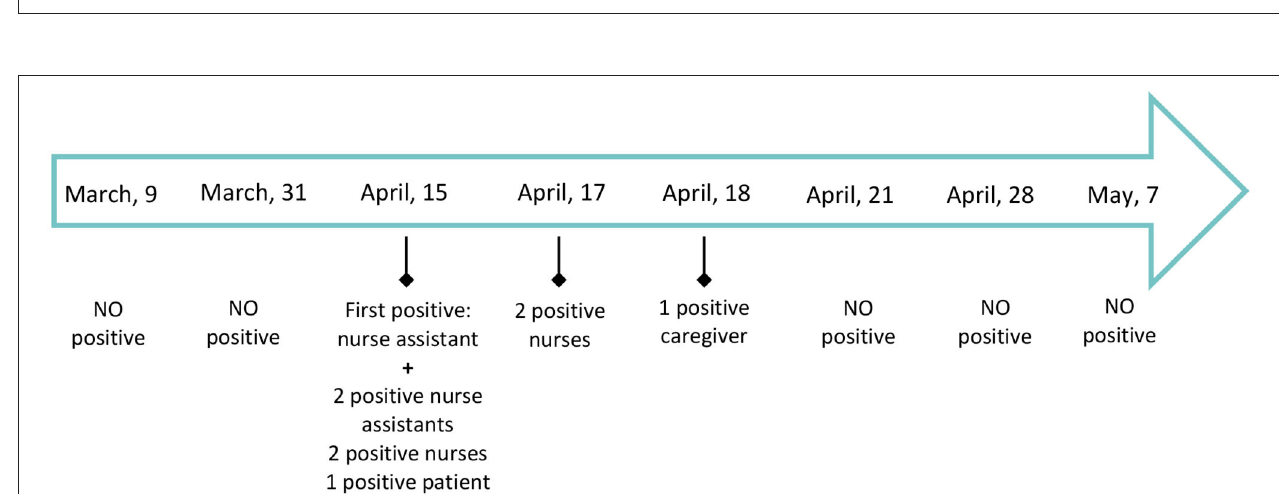
FIGURE 3 | Timeline showing the positive COVID-19 cases in our Unit between March, 1st and May 7th, 2020. As April 28th, 2020, 32 patients and caregivers had been tested and a total of 68 rT-PCR diagnostic assays had been done: two positive cases were identified, only one of them with mild symptomatology. One hundred and six healthcare workers were tested with a total of 208 rT-PCR diagnostic assays: seven positive cases were identified of whom four presented any symptomatology. No more positive tests have been found since April, 18th.